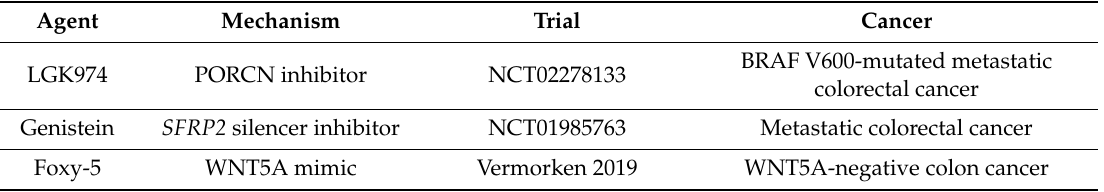
Table 1. Agents inhibiting Wnt signaling for GI cancers in phase II clinical